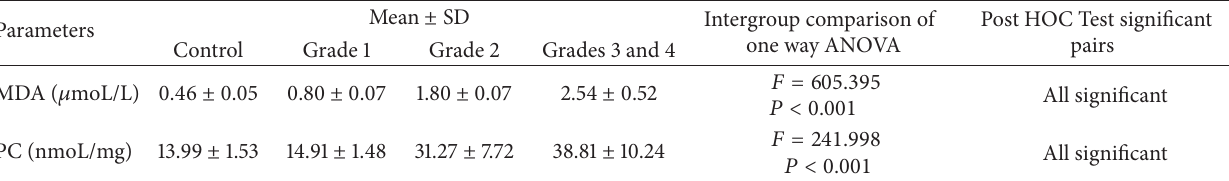
Table 2: Oxidants in different grades of PEM.